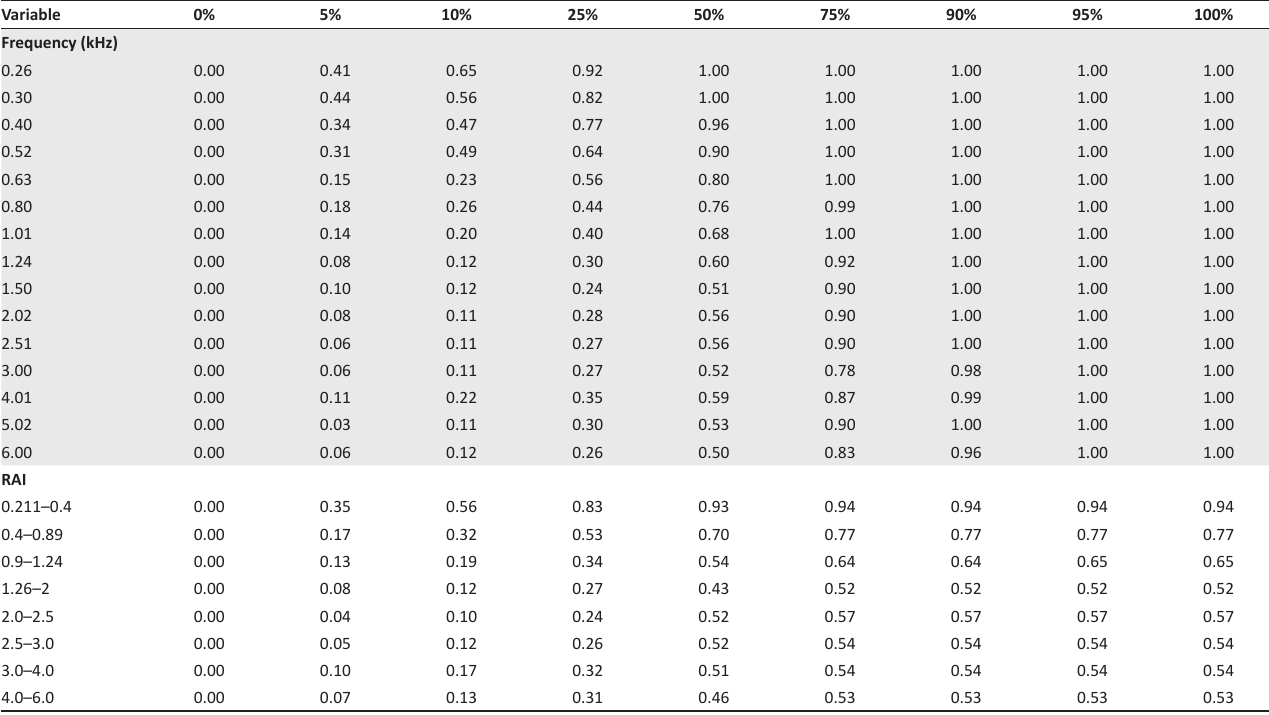
TABLE 3: Mean reflectance and RAI values for 0.26 kHz – 6 kHz NICU neonates by using chirp stimuli ( n = 75 ears). Variable